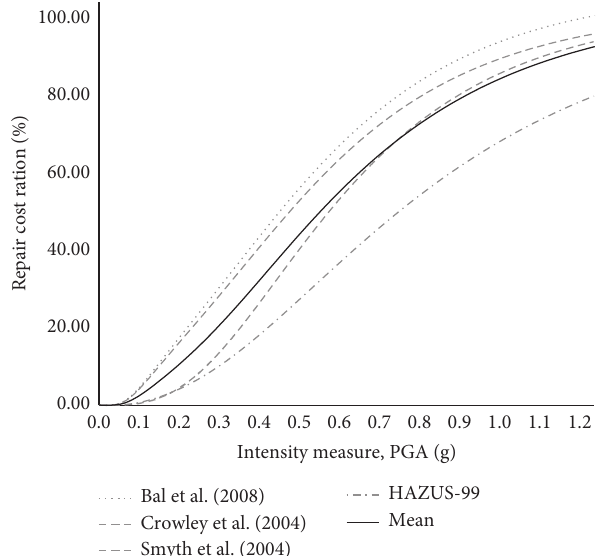
Figure 18: Seismic vulnerability curve derived for considered deficient RC frame building